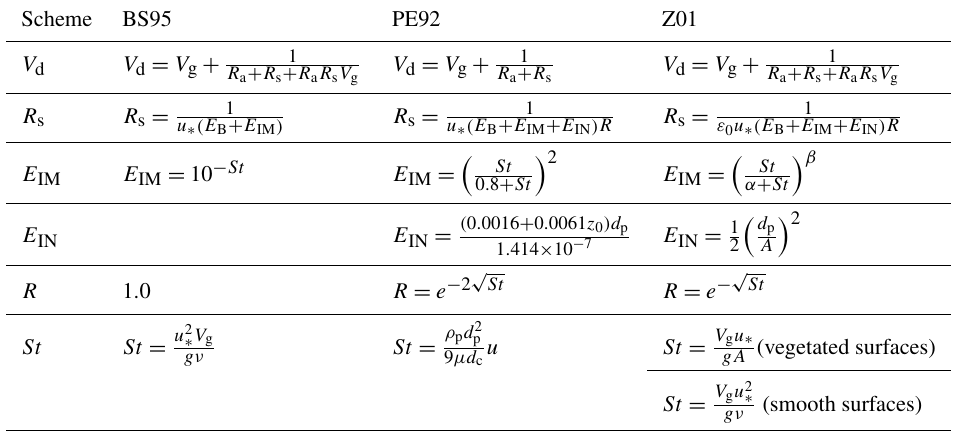
Table 2. Three dry deposition schemes. Scheme